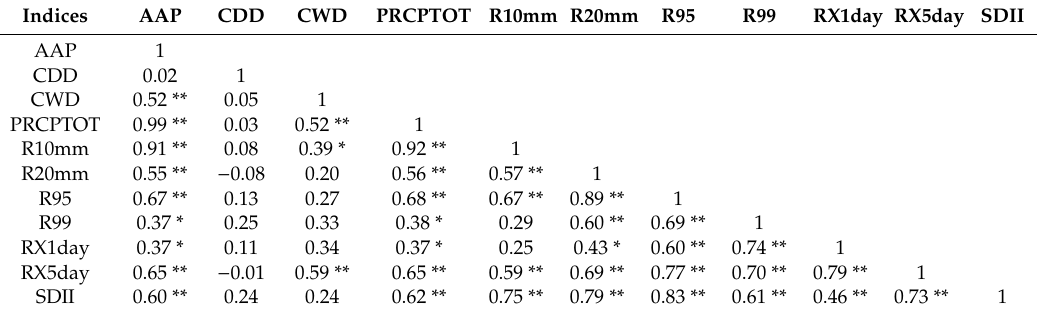
Table A1. Correlation coe ffi cients between annual average precipitation (AAP) and the extreme precipitation indices in alpine meadow.